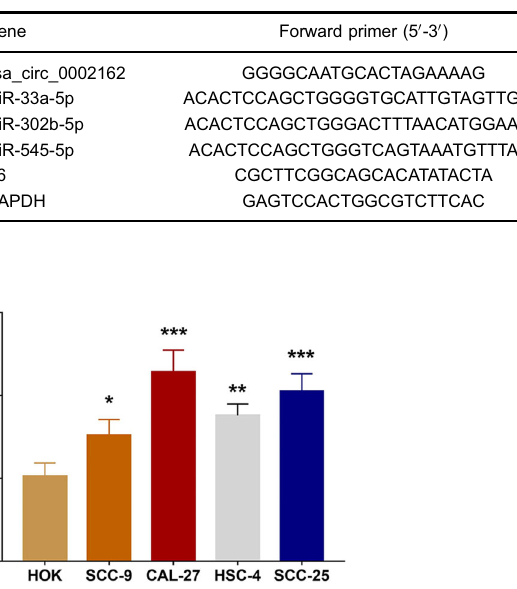
Table 1. Primer sequences used in the study.